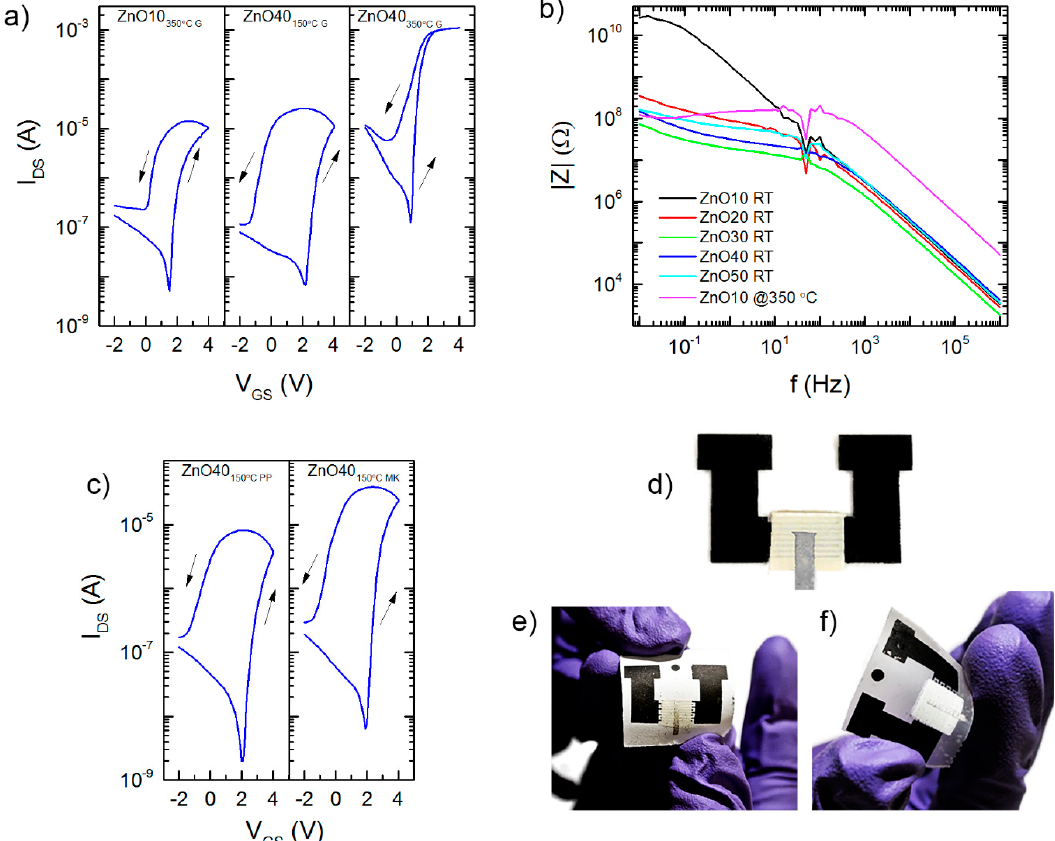
Figure 3. ( a ) Representative transfer characteristics (I DS –V GS ) of the ZnO NP EGTs on glass, namely ZnO10 EGT annealed at 350 °C (ZnO10 350 °C Glass (G) ); the ZnO40 EGT under processing temperatures of